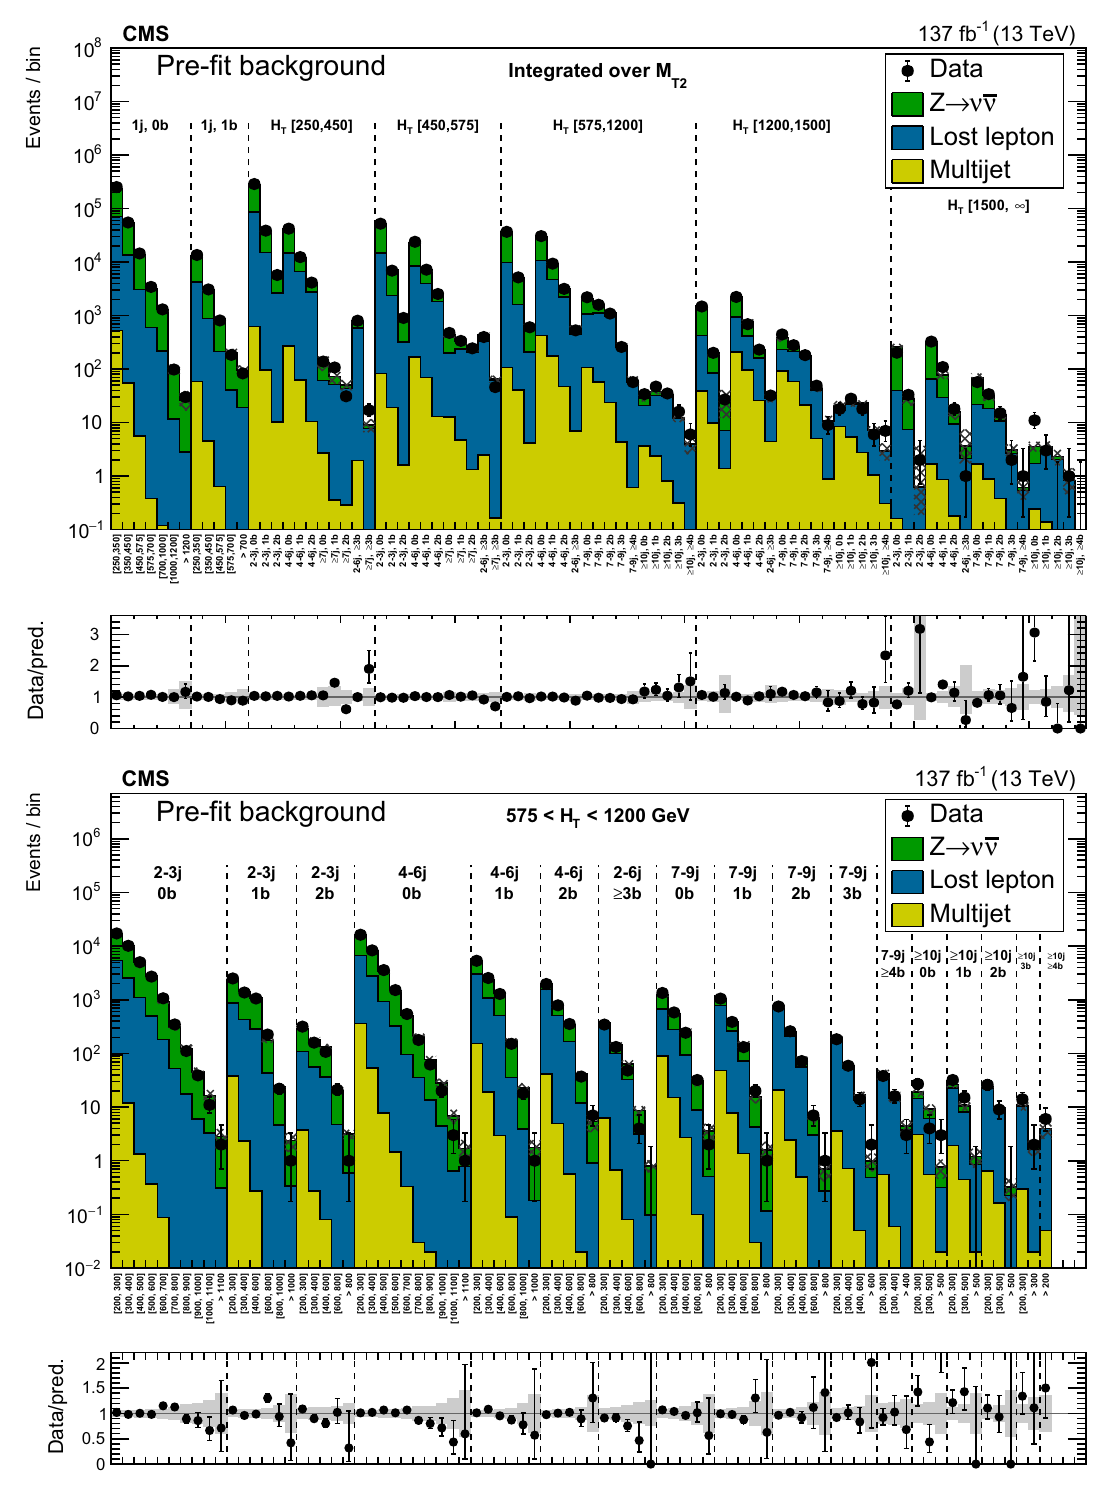
Fig. 5 (Upper) Comparison of the estimated (pre-fit) background and observed data events in each topological region. The hatched bands represent the full uncertainty in the background estimate. The monojet regions ( N j = 1) are identified by the labels “1j, 0b” and “1j, 1b”, and are binned in jet p T . The multijet regions are shown for each H T region